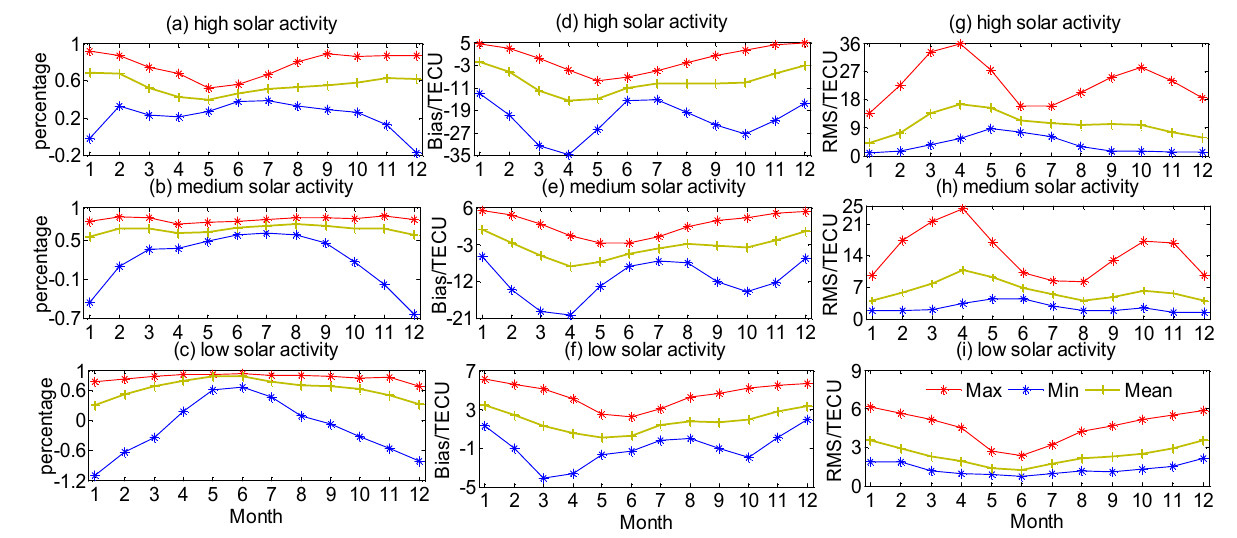
Fig.6 Correction, Bias and RMS of each month during high, medium and low solar